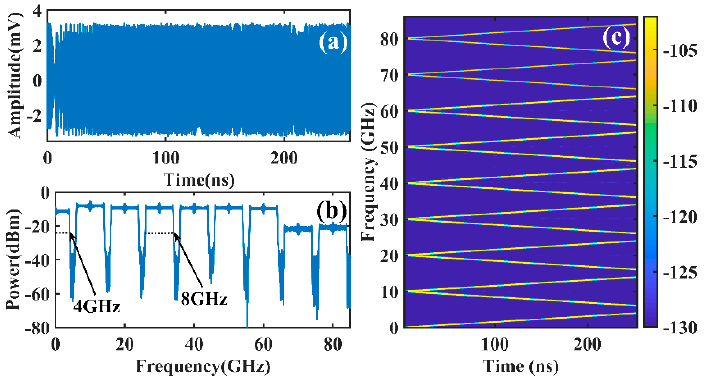
Figure 6. ( a ) The waveform, ( b ) spectrum, and ( c ) time-frequency diagram of the chirped signal.